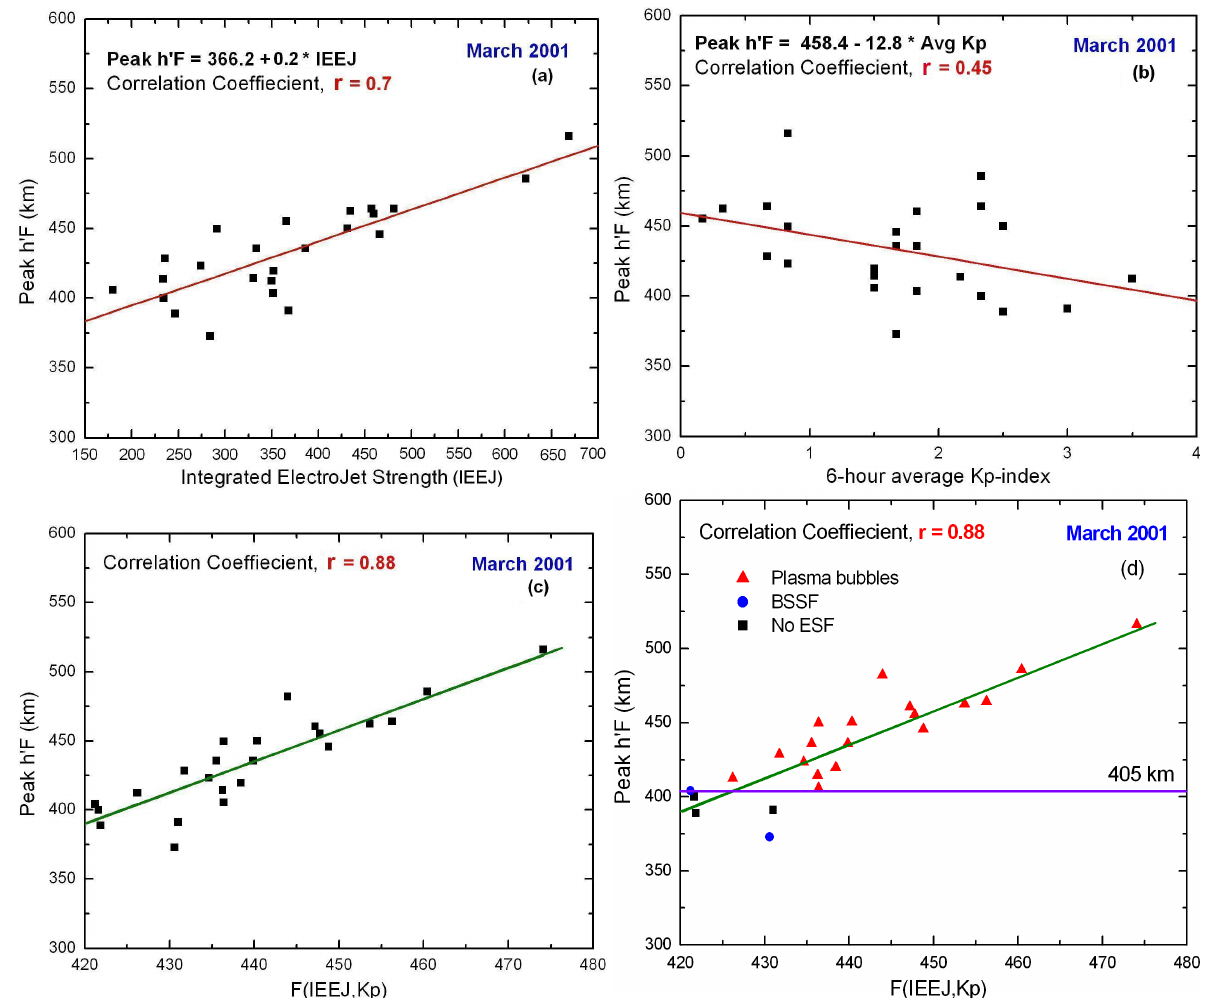
Fig. 3. Plots showing the linear relationship of peak h 0 F values with IEEJ and average K p -index (a) peak h 0 F as a function of IEEJ strength, (b) peak h 0 F as a function of 6-h average K p -index prior to the sunset, (c) peak h 0 F values as a function of the combined parameter F (IEEJ, avg K p ), and (d) peak h 0 F values as a function of the combined parameter F (IEEJ, avg K p ) with color coding (the red triangles representing the peak h 0 F values for the days on which plasma bubbles were observed, while the blue circles represent the days on which only bottom side spread-F (BSSF) was observed and the black squares represent the days on which no ESF was